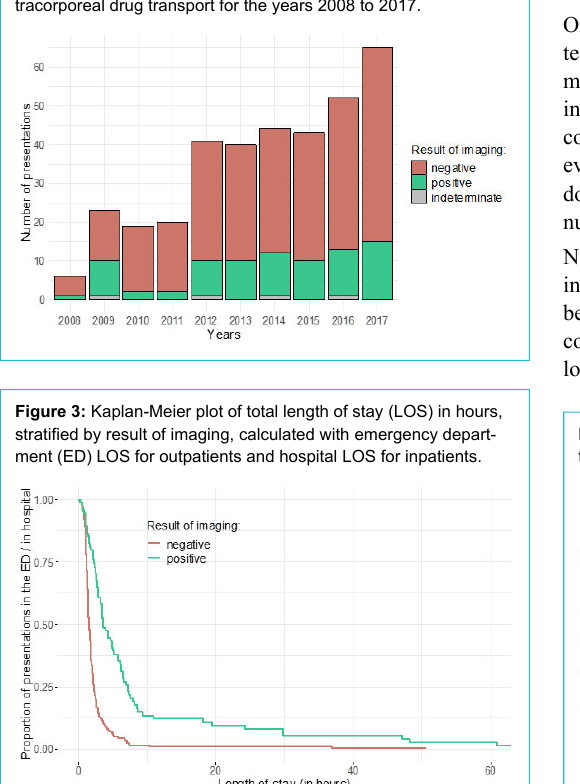
Figure 2: Results of imaging in presentations with suspicion of in- tracorporeal drug transport for the years 2008 to 2017.